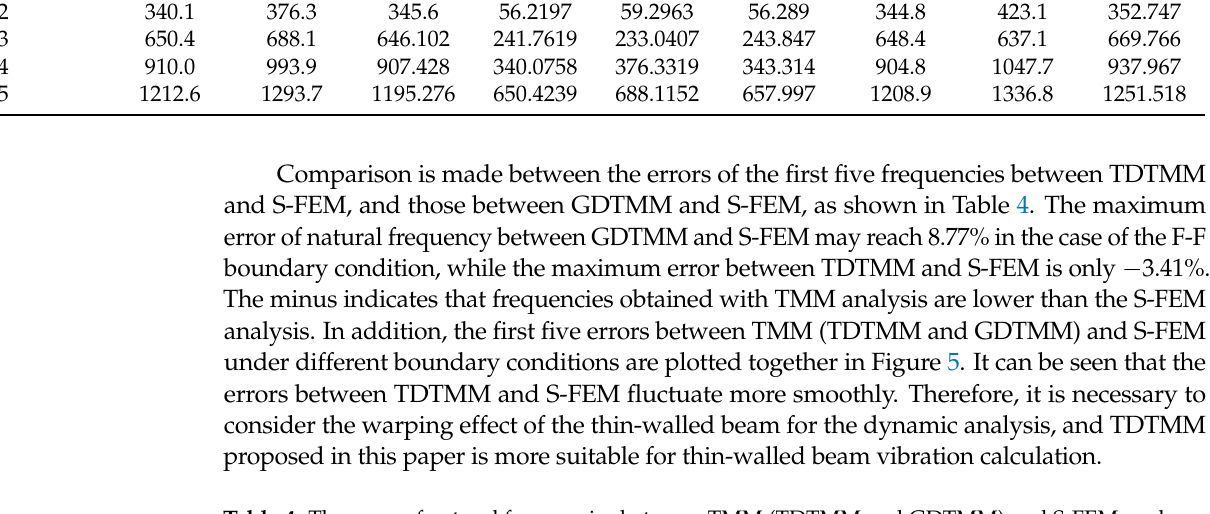
Table 4. The error of natural frequencies between TMM (TDTMM and GDTMM) and S-FEM analyses in example